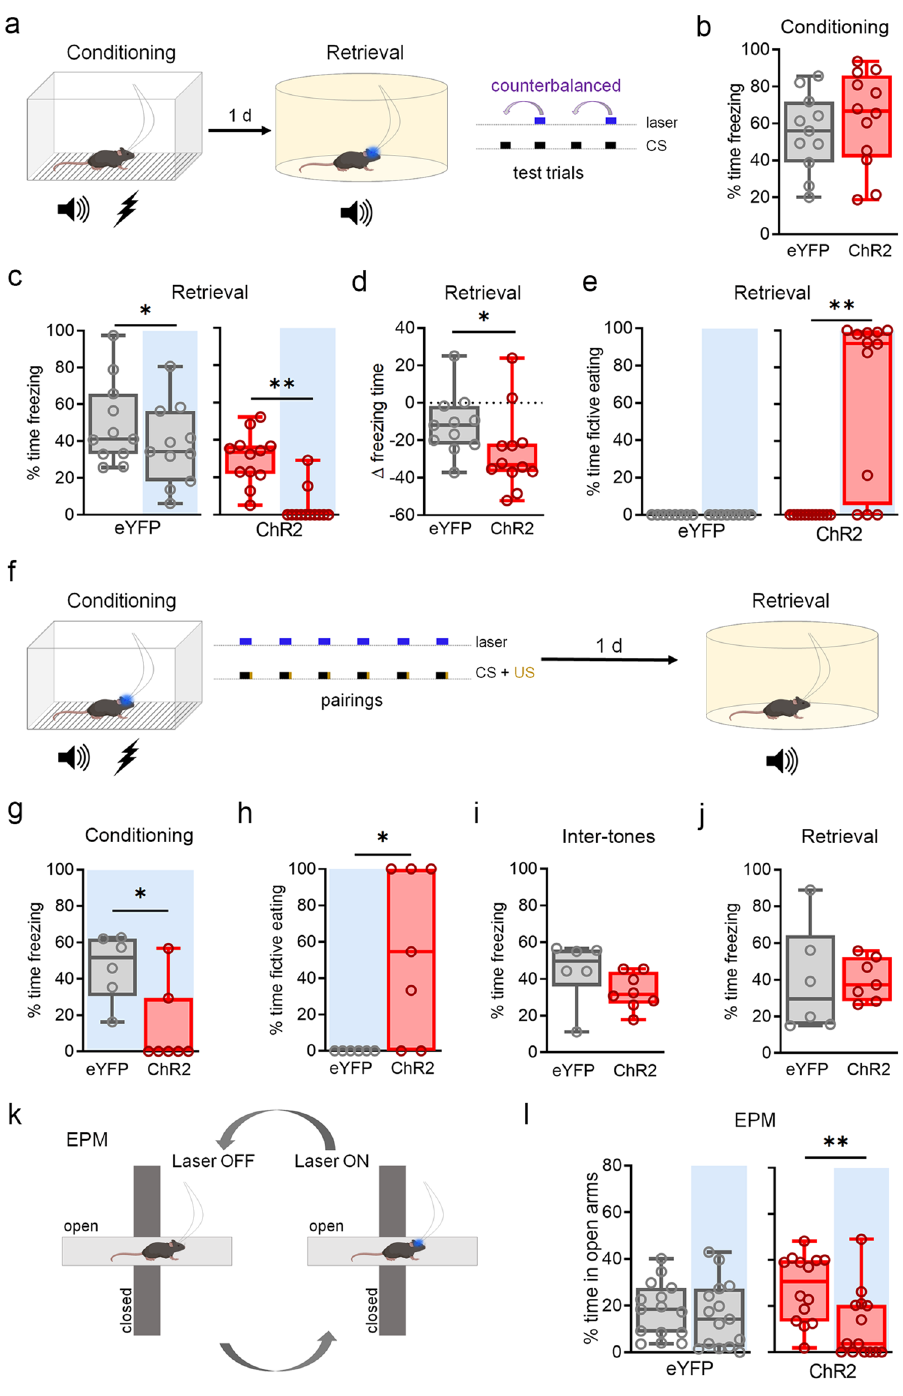
Figure 3. BF GAD2+ neuron activation disrupts conditioned fear expression but not learning. ( a ) Design for test of fear memory expression. Following conditioning in context A, animals were placed into a distinct arena (context B) and presented with 4 CS trials, two of which coincided with photostimulation, in a counterbalanced fashion. ( b ) Freezing levels during final two CS trials of conditioning. ( c ) CS-evoked freezing during laser ON vs. laser OFF CS trials. ChR2, Wilcoxon signed rank test, W = − 66, **p < 0.01. eYFP, paired t-test, t 10 = 2.40, *p < 0.05. ChR2, n = 12; eYFP, n = 11. ( d ) Difference in freezing during laser ON vs. laser OFF CS trials. ChR2, n = 12; eYFP, n = 11. ( e ) Fictive eating during laser ON vs. laser OFF CS trials. ChR2, Wilcoxon signed rank test, W = 45, **p < 0.01. ( f ) Design for test of fear learning. During fear conditioning (context A) mice were presented with 6 CS-US pairings that coincided with laser stimulation, and on the following day were tested for long-term memory by exposure to 2 CS trials in the absence of laser stimulation in a context distinct from the training arena (context B). ( g ) Freezing levels across all CS trials of conditioning. Mann–Whitney test, U = 4, *p < 0.05. ChR2, n = 7; eYFP, n = 6. ( h ) Fictive eating during CS trials. Mann–Whitney test, U = 6, *p < 0.05. ChR2, n = 7; eYFP, n = 6. ( i ) Freezing levels during inter-CS intervals. ChR2, n = 7; eYFP, n = 6. ( j ) CS-evoked freezing during the retrieval test. ChR2, n = 7; eYFP, n = 6. ( k ) Design for test of anxiety-like behavior using the elevated plus maze (EPM). ( l ) Percent time spent in open arms during laser ON vs. laser OFF epochs. ChR2, Wilcoxon signed rank test, W = − 89, **p < 0.01. ChR2, n = 15; eYFP, n = 15. Schematics ( a , f , k ) were created using BioRender.com and